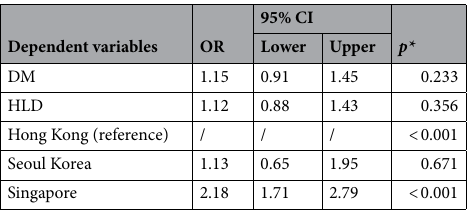
Table 5. Risk factors of moderate-to-severe white matter lesion. This table shows the vascular risk factors contributing to moderate-to-severe white matter lesion. Age, sex, level of education, Asian cities, disease groups, and image modality are entered as covariates in each regression model as appropriate. DM Diabetes mellitus, HLD Hyperlipidemia, HT Hypertension. *Bonferroni correction is applied to the alpha ( α = 0.0125).